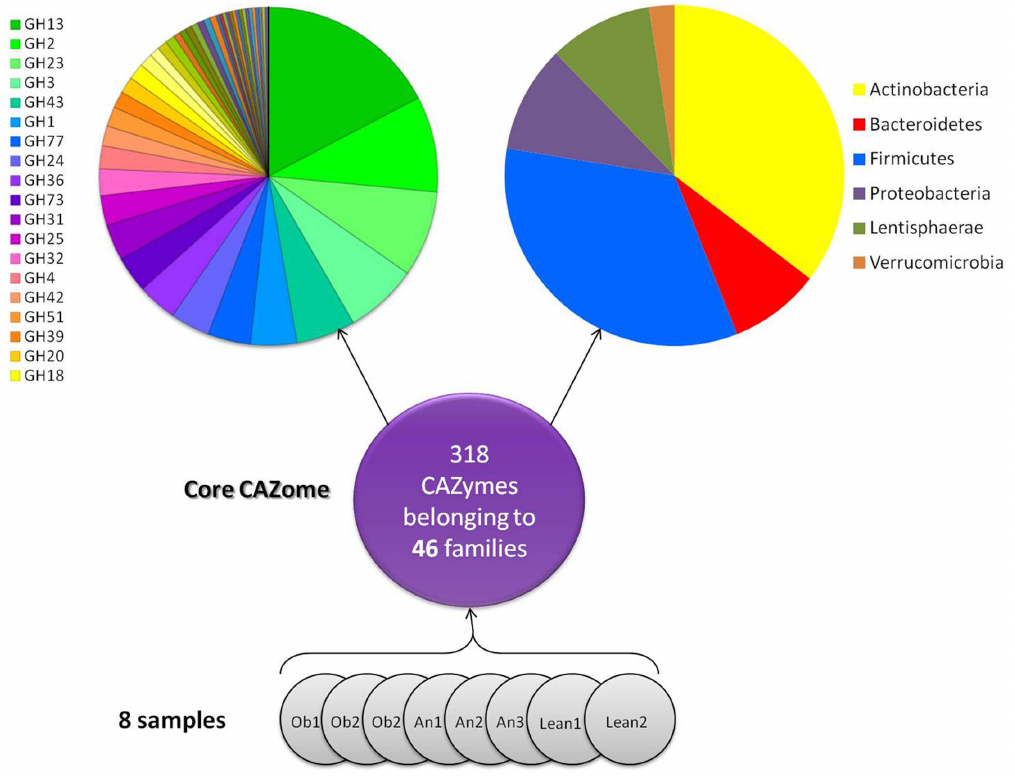
Figure 3. CAZy family content and the associated phyla classification of the core CAZome. A total of 318 CAZyme genes were commonly detected in the eight samples and composed the core CAZome. The proportions of corresponding CAZy families are shown in rainbow colors. The phylum distribution of the core CAZyme genes within each group are shown in different colors (blue, Firmicutes; red, Bacteroidetes; yellow, Actinobacteria; purple, Proteobacteria; olive green, Lentisphaerae; brown, Verrucomicrobia).